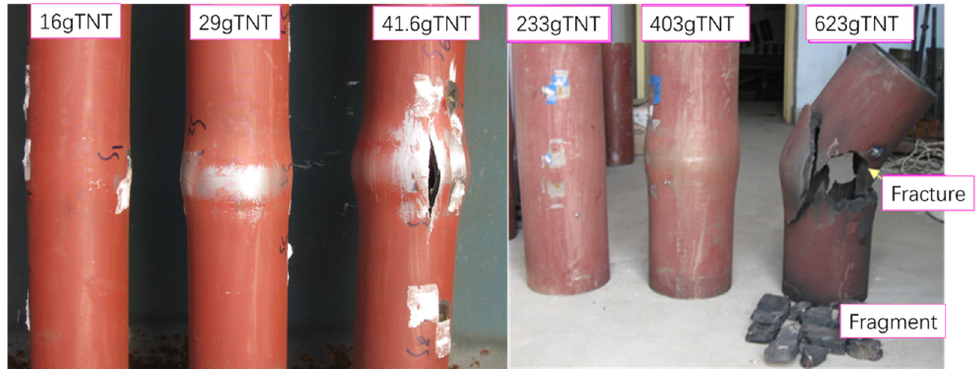
Figure 4. Shell deformation experiment picture of 0.8 m and 2 cm thickness.